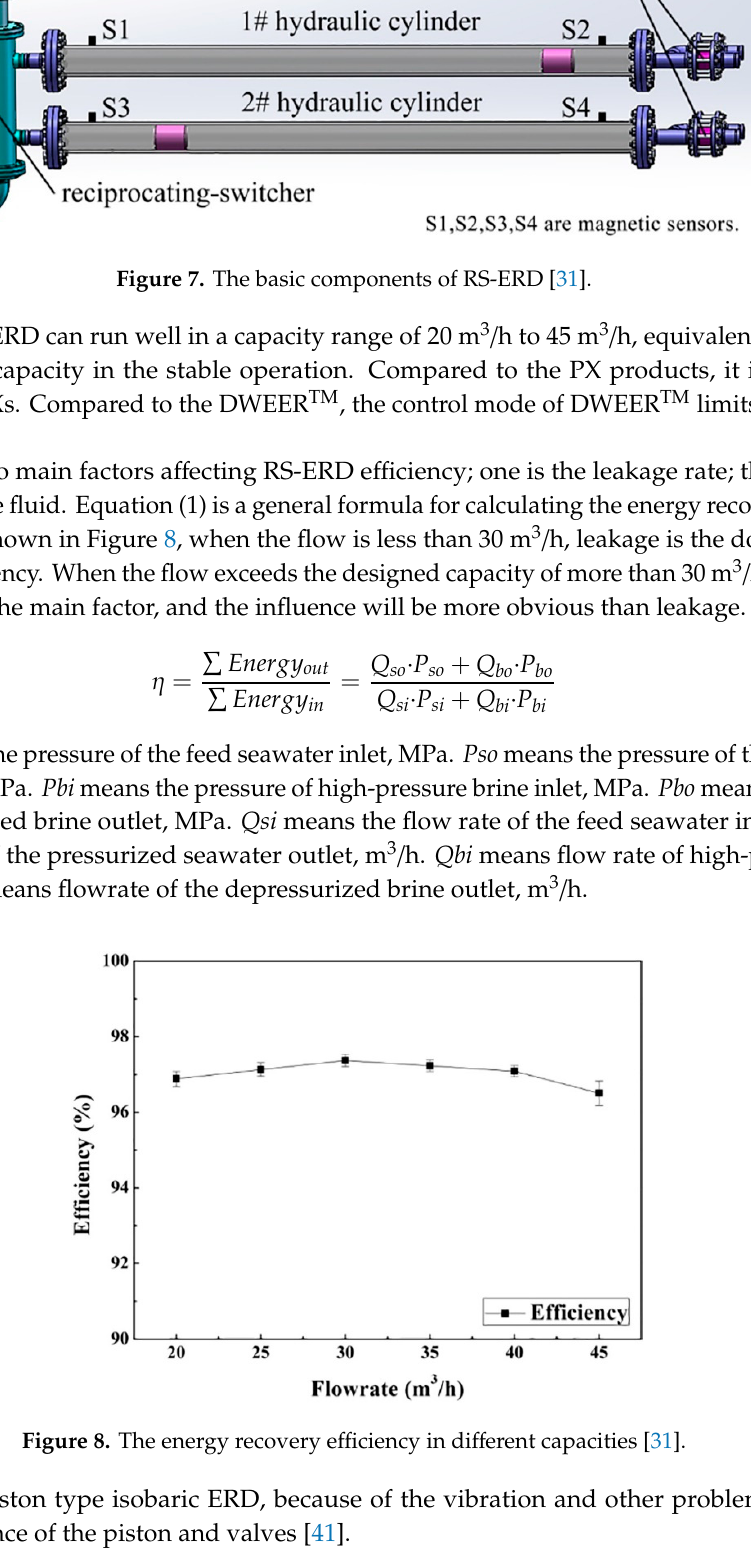
Figure 8. The energy recovery efficiency in different capacities [ Error! Reference source not found. ].